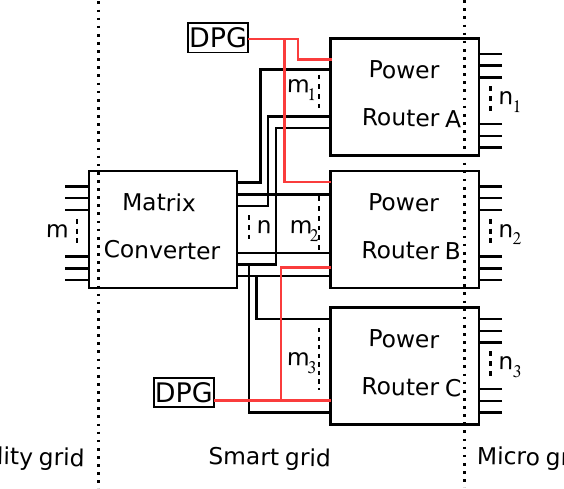
Figure 2. Generalized idea of matrix converter and power routers. All can have multiple input/output ports and various decentralized power generators (DPG) are distributed within the